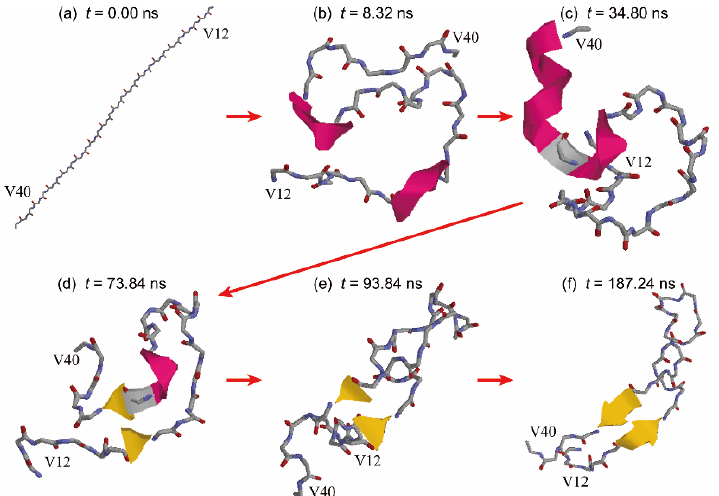
Figure 8. Time-series snapshots of A β 40 at the interface at ( a ) t = 0.00 ns, ( b ) t = 8.32 ns, ( c ) t = 34.80 ns, ( d ) t = 73.84 ns, ( e ) t = 93.84 ns, ( f ) t = 187.24 ns. Residues D1 − E11 was omitted for the sake of clarity. Reprinted with permission from Reference [25]. Copyright 2019 American Chemical Society.